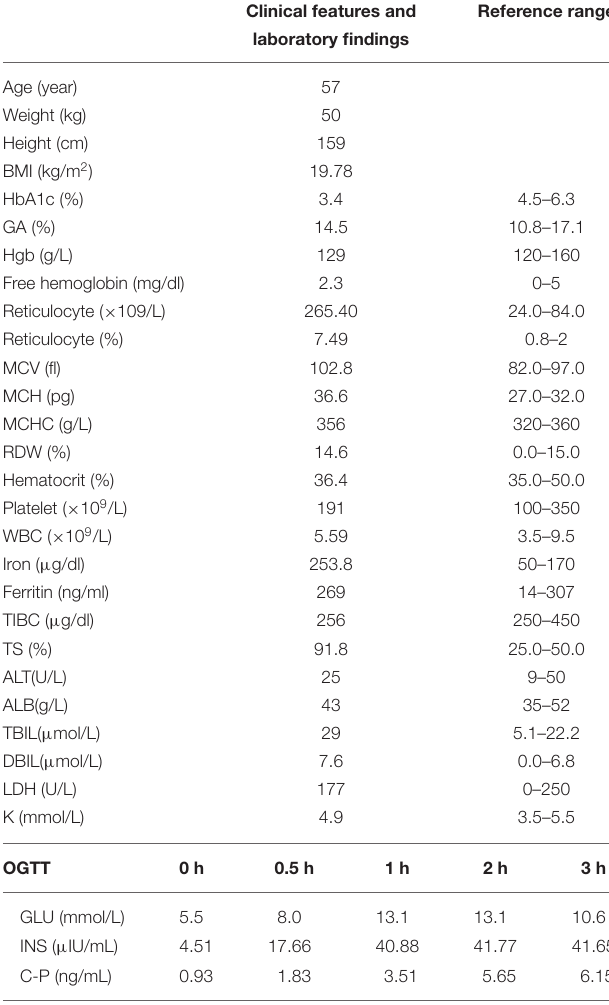
TABLE 1 | Clinical features and laboratory results of this